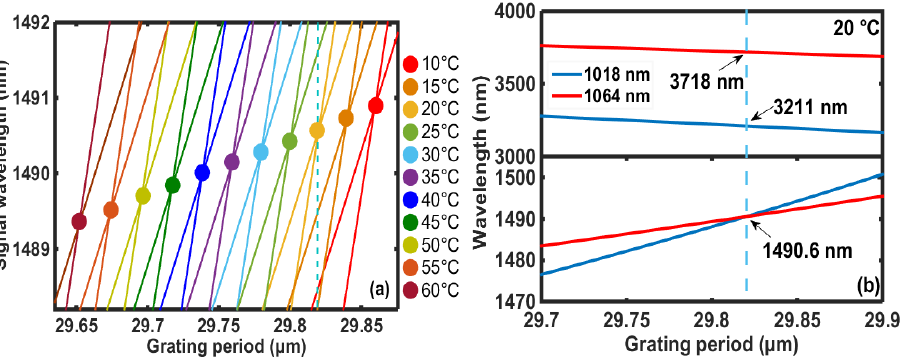
Figure 3. ( a ) Simulated tuning curves at different periodically poled lithium niobate (PPLN) temperatures when the pump wavelength is 1018 nm and 1064 nm separately. ( b ) The calculated signal and idler wavelengths corresponding to 1018 nm and 1064 nm pump beams at 20 °C.